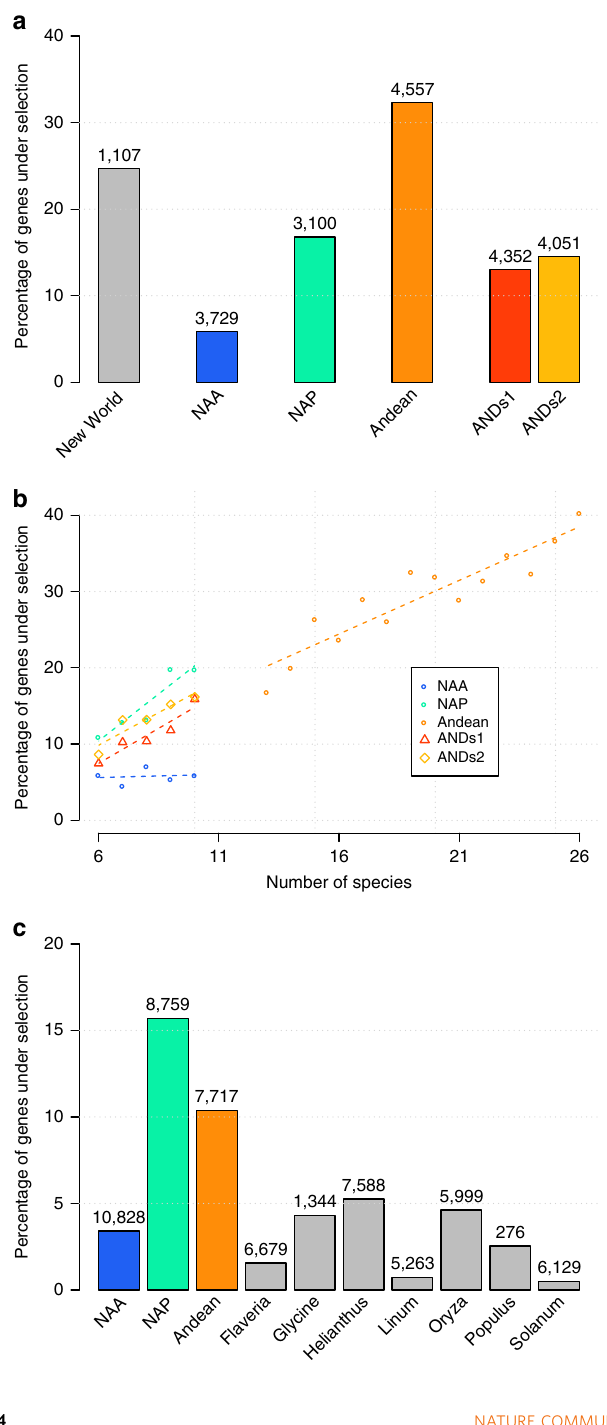
Figure 2 | Phylogenetic analysis of selection on coding sequences. ( a ) Percentage of genes evolving under positive selection in the different Lupinus lineages (New World—all species; NAA; NAP; ANDs1 and ANDs2 are random subsets of 10 Andean species). ( b ) The effect of the number of species used on the power to detect selection. Because of missing data, different genes were sampled in a variable number of species. The graph shows the percentage of genes inferred to contain sites evolving under positive selection, for each group and according to the number of species sampled. Results are only shown for points where 100 or more genes were tested. ( c ) Percentage of genes evolving under positive selection across seven plant genera with transcriptomes available for sets of species, compared with the different Lupinus lineages studied. Each group was tested using between six and eight species. For a and c values depicted are averages across all genes sampled in at least six species, and numbers on top of bars denote number of genes tested for selection with each